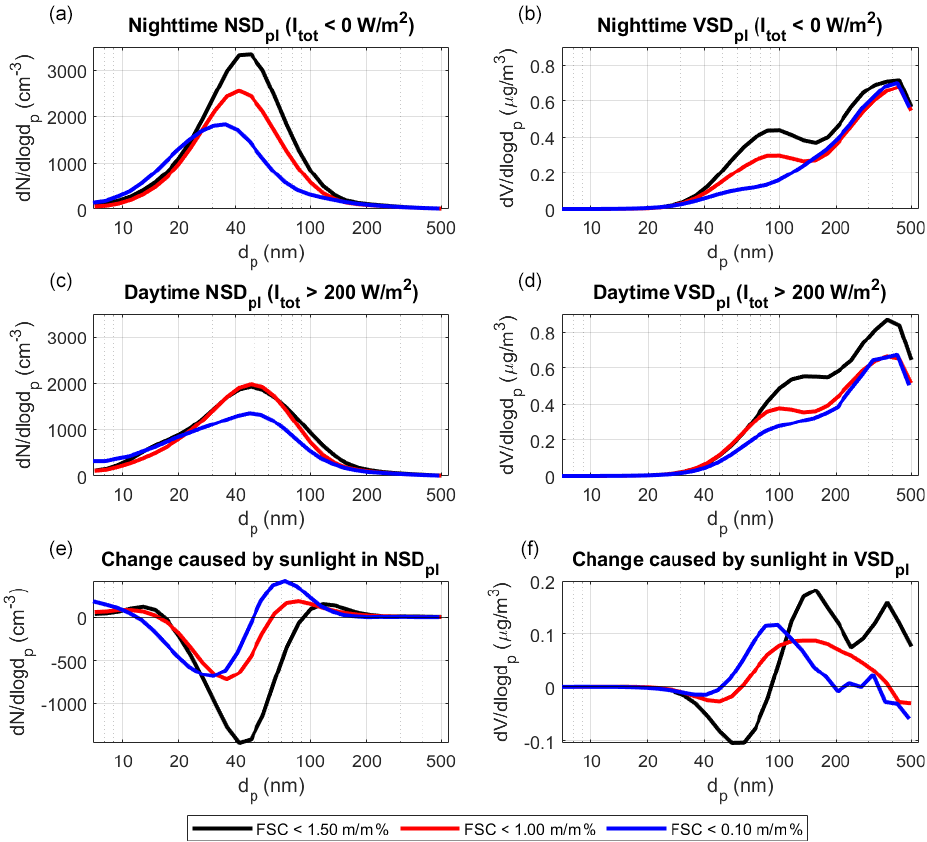
Figure 12. Average number size distributions (NSD pl ) and volume size distributions (VSD pl ) of the plumes in the 220–260 ◦ sector for the three fuel sulfur content (FSC) restriction periods for nighttime and daytime: (a) nighttime NSD pl , (b) nighttime VSD pl , (c) daytime NSD pl , (d) daytime VSD pl , (e) change in NSD pl caused by exposure to sunlight, and (f) change in VSD pl caused by exposure to